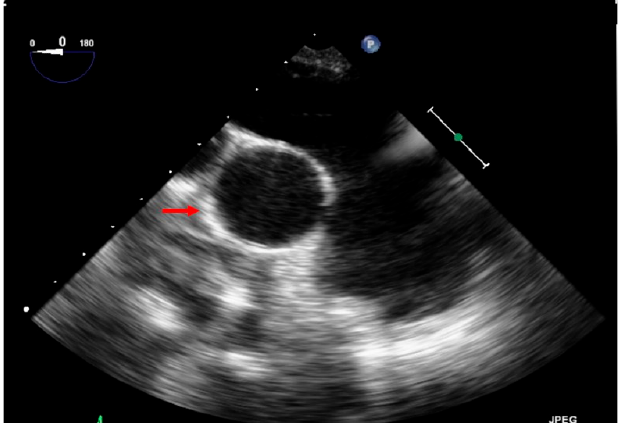
Figure 12. This echocardiography shows the dilated pulmonary artery in comparison to the aorta (red arrow on the aorta). Table 1 summarizes characteristics and clinical courses of the three patients treated with surgery. Table 1. Characteristics of surgical patients.